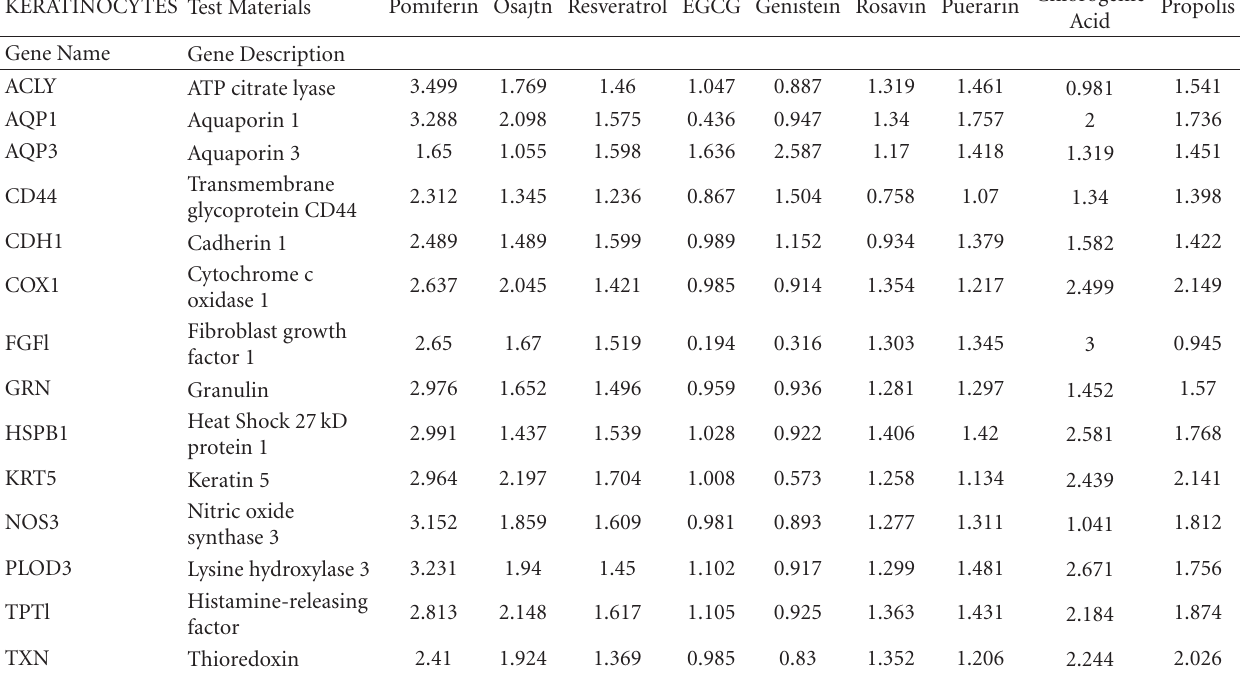
Table 5: Summary of keratinocyte genes noted to be commonly upregulated by the antioxidant treatments. KERATINOCYTES Test